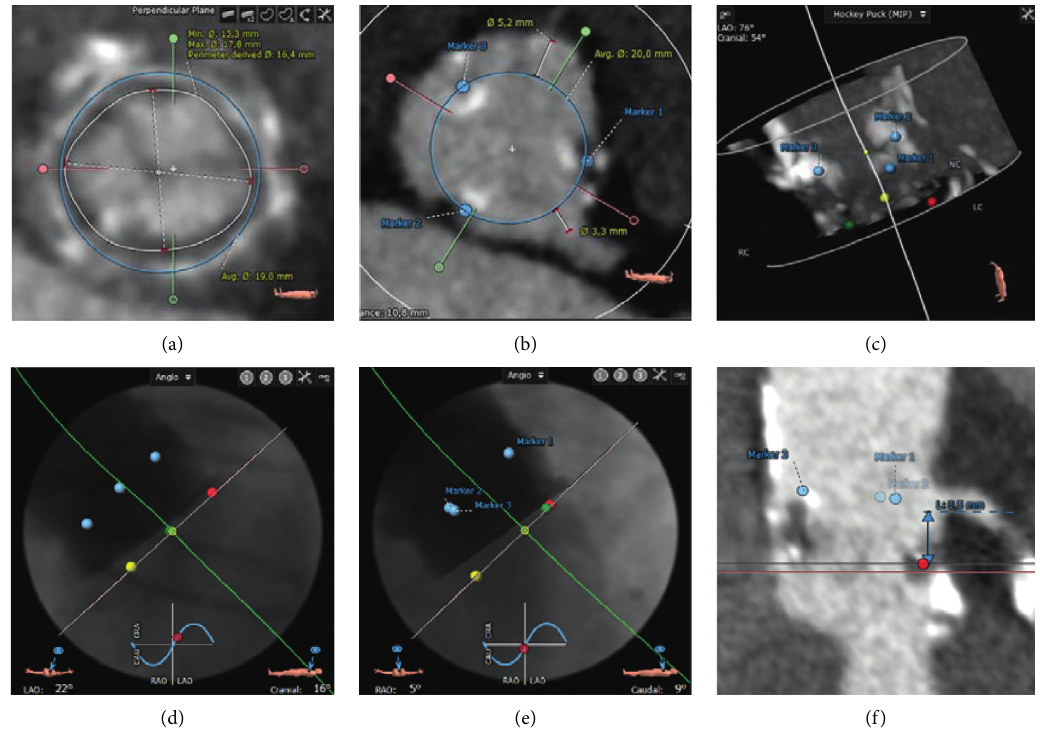
Figure 3: Preprocedural CT planning in a 91-year-old female patient with high-grade aortic stenosis (peak gradient 64mmHg and mean gradient 35mmHg) that underwent ViV-TAVI in a failed 21mm Epic bioprosthesis. (a) The basal ring of the Epic valve is marked at the center of the cusps (red, blue, and green dots). The stent diameter is 19mm, and true internal diameter is 16.4mm (17mm according to the aortic ViV app, with internally mounted leaflets). (b) The posts of the stent of the Epic valve are marked with generic markers (blue). The blue circle is centered on the surgical valve and represents the waist of the planned 23mm Evolut valve. The distance between the virtual 23mm valve (with the waist of 20 mm) and the left coronary (virtual transcatheter valve-to-coronary ostium distance, VTC) is low (3.3mm). (c) Hockey puck view showing the generic blue markers on the top posts, while the colored markers are in the middle of the cusps at the base of the surgical valve. (d) Coplanar view with the left coronary cusp at the right side (red marker). (e) Cusp-overlap view with overlapping left and right coronary cusps (red and green markers). (f) Low left coronary height (8.5mm) with shallow sinuses of